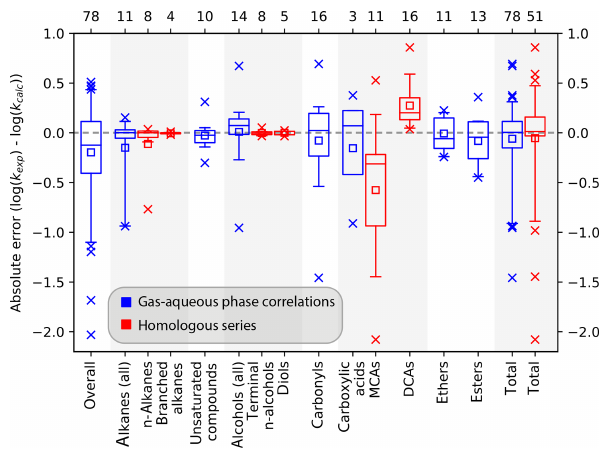
Figure 1. Box plots of the absolute errors of the logarithmized ex- perimental versus predicted OH rate constants for the prediction of OH rate constants with gas–aqueous-phase correlations (blue boxes) and extrapolations of homologous series (red boxes). Boxes represent the quartiles of the absolute errors, whiskers the 95% con- fidence interval, data points outside this are shown explicitly. The arithmetic mean is represented by a square. The “overall” box repre- sents absolute errors from a gas–aqueous-phase correlation derived from a fit of all data, while the total column denotes the evaluation of all errors compiled from the analysis of the various compound